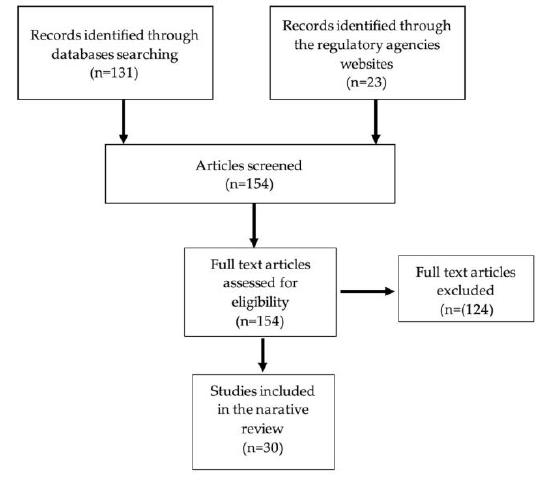
Figure 1. Flowchart describing literature search.